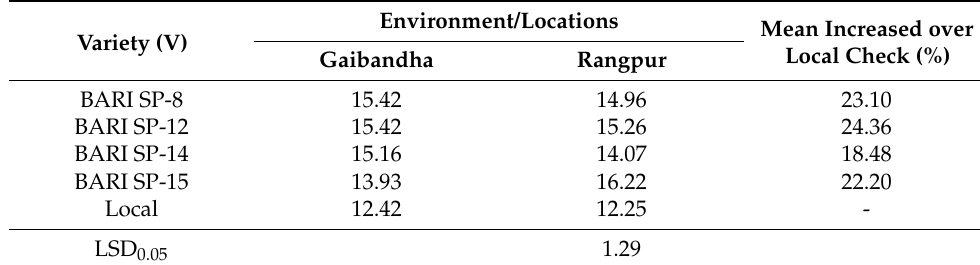
Table 5. Interaction effect of variety (V) and environment (E) on root length of sweet